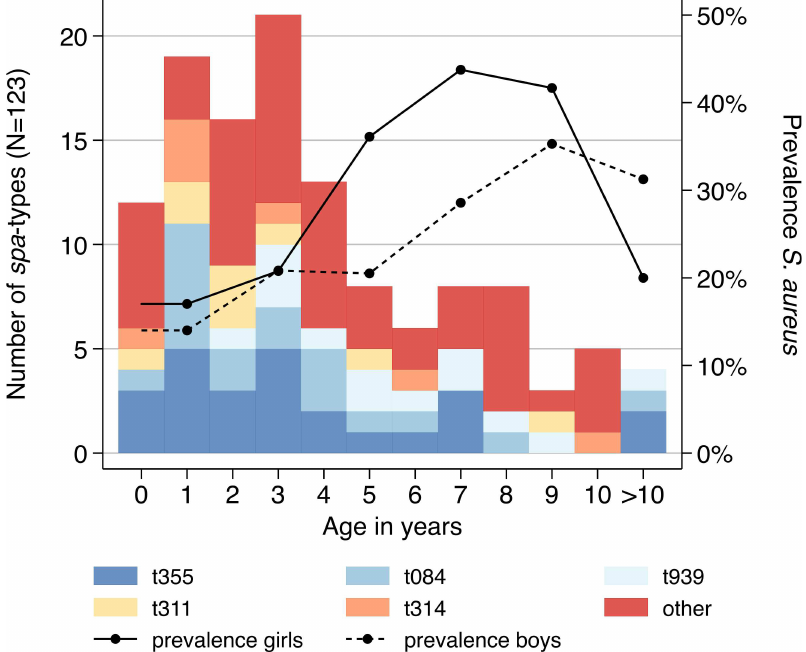
Fig 1. Age and sex distribution of spa -types. Distributionof spa -types(n = 123) and nasal Staphylococcus aureus prevalenceby 2-years age-groups and sex (n = 544). Girls (continuousline) are colonizedwhen they are approximately 2 years youngerthan boys (dashedline).